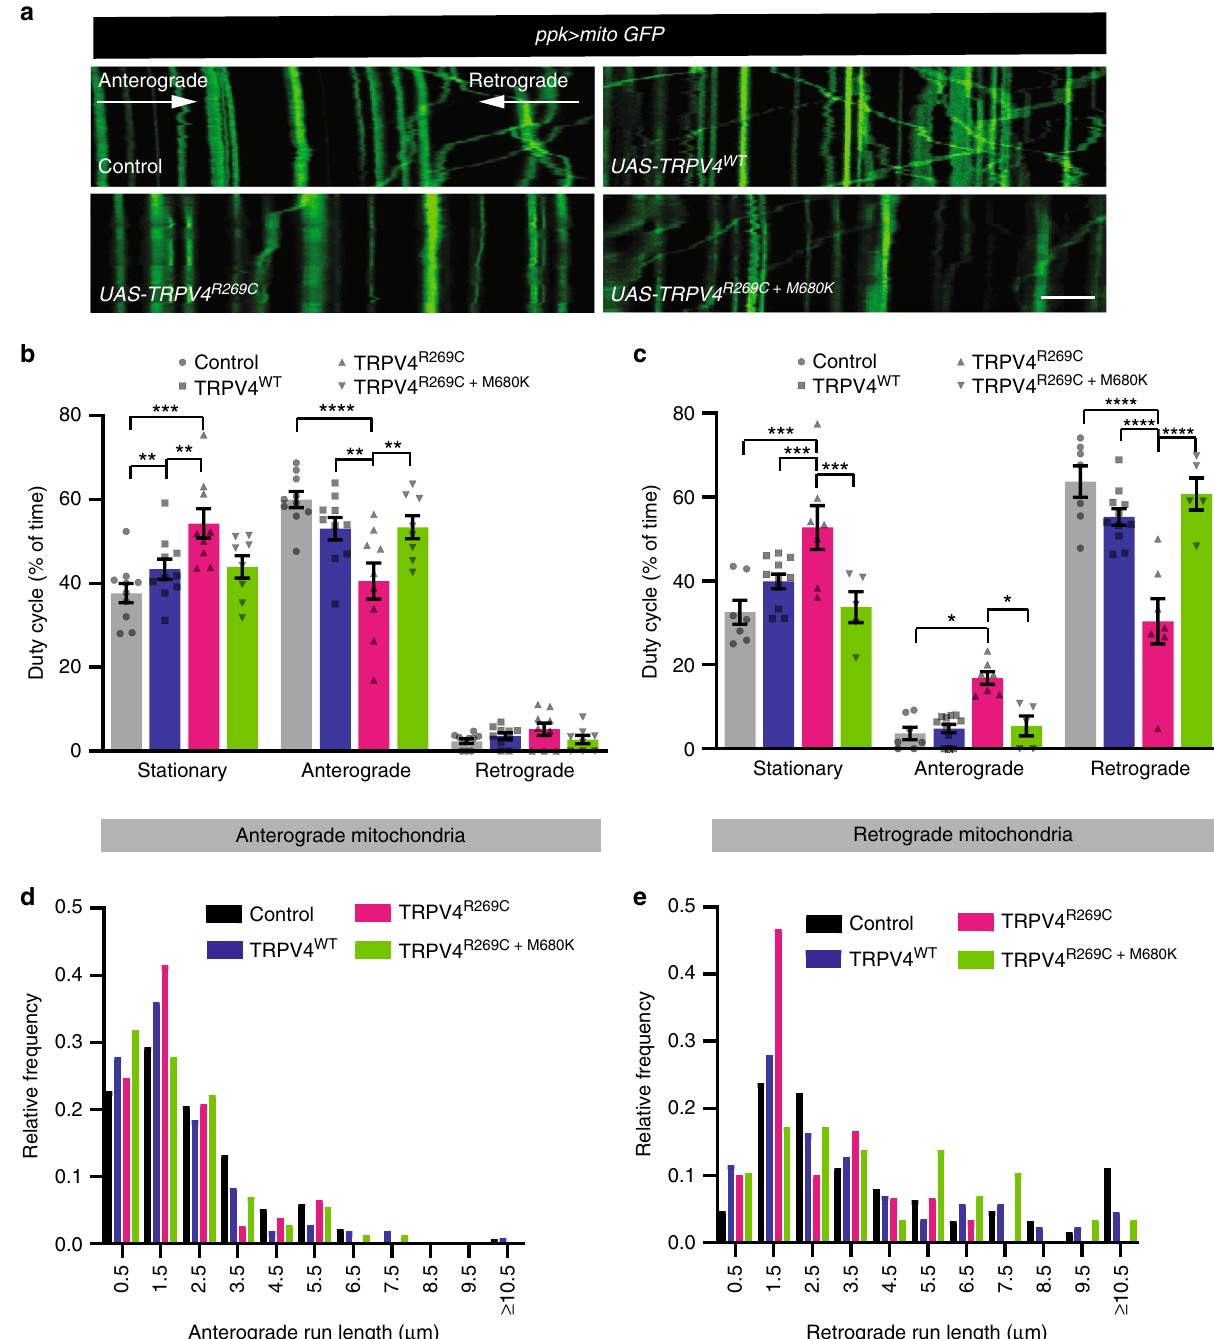
Fig. 6 Mitochondrial axonal transport is disrupted by TRPV4 R269C prior to axonal degeneration. a Kymographs of mito-GFP transport in the proximal axon of C4da neurons expressing the indicated TRPV4(mod) variants. Scale bar, 10 μ m. Quanti fi cation of b anterograde duty cycle and c retrograde duty cycle. For control, TRPV4 WT , TRPV4 R269C , TRPV4 R269C + M680K n = 10, 10, 9, 8 and 7, 11, 7, 5 larvae for anterograde and retrograde, respectively. Mean ± SEM. Two-way ANOVA ( p < 0.0001), Tukey ’ s post hoc test. Frequency distributions of d anterograde and e retrograde mitochondrial run lengths. For control, TRPV4 WT , TRPV4 R269C , TRPV4 R269C + M680K : n = 12, 11 , 14, and 10 larvae; 138, 108, 77, and 72 anterograde and 63, 86, 30, and 29 retrograde runs, respectively. For all panels: * p < 0.05, ** p < 0.01, *** p < 0.001, **** p <